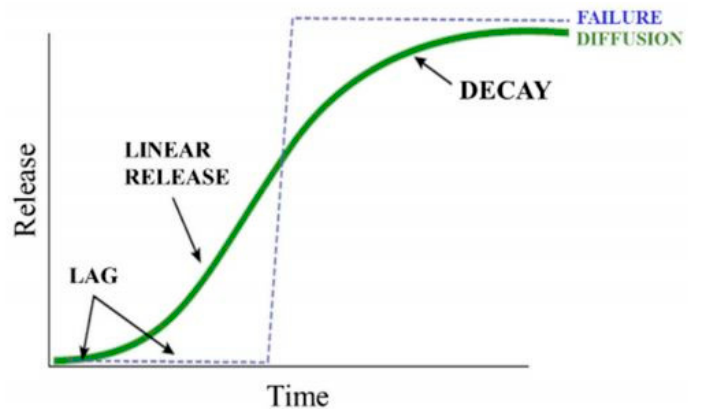
Figure 2. Sigmoidal curve for slow-release fertilizer (green) and failure release (blue). Reproduced from [26].